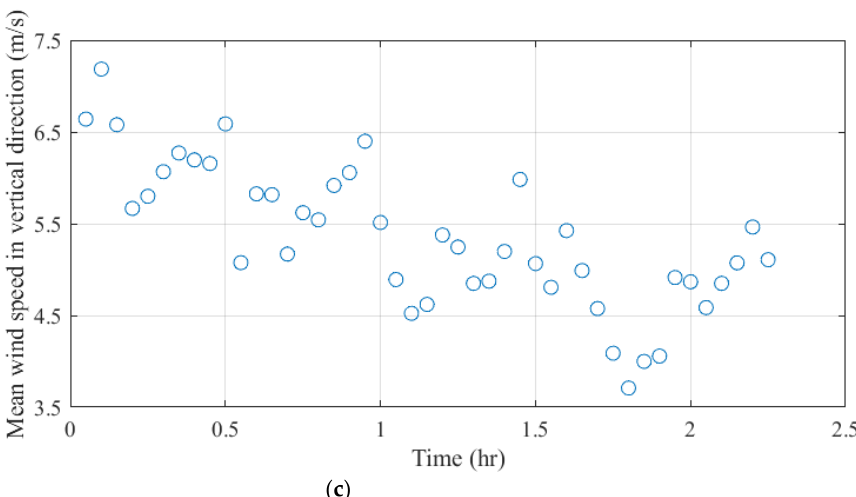
Figure 5. Variations in mean wind speed, mean wind direction, and mean wind speed in vertical direction: (a) mean wind speed; (b) mean wind direction; (c) mean wind speed in the vertical direction.